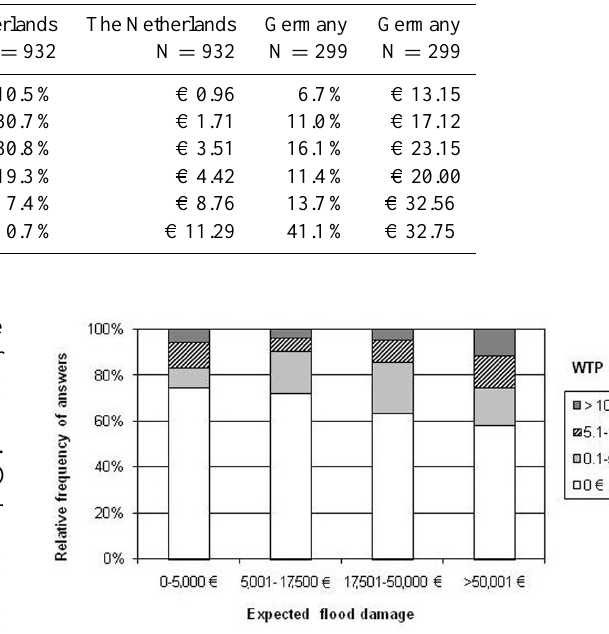
Fig. 5. Expected flood damage in the Netherlands and the corre- sponding frequency of answers of willingness to pay (WTP) for flood insurance by private